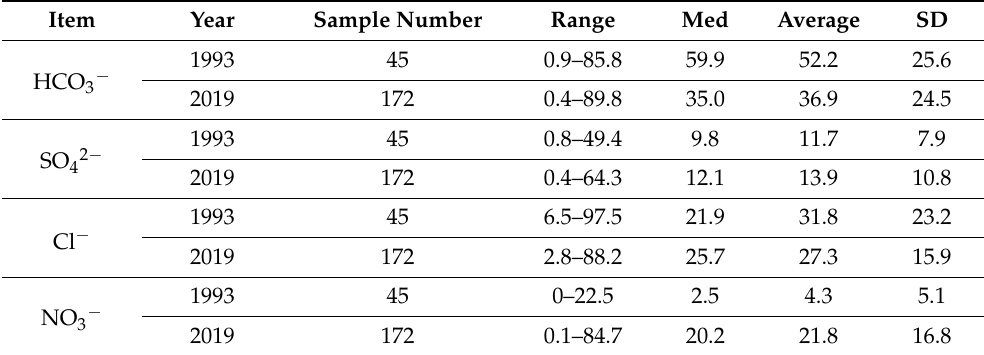
Table 3. Characteristic parameters of the relative contents of major anions in the groundwater of